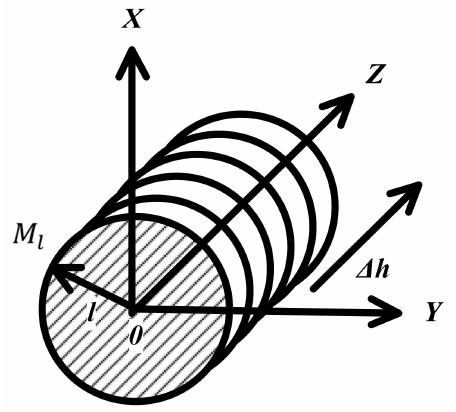
Figure 4. Horizontal resolution of measured